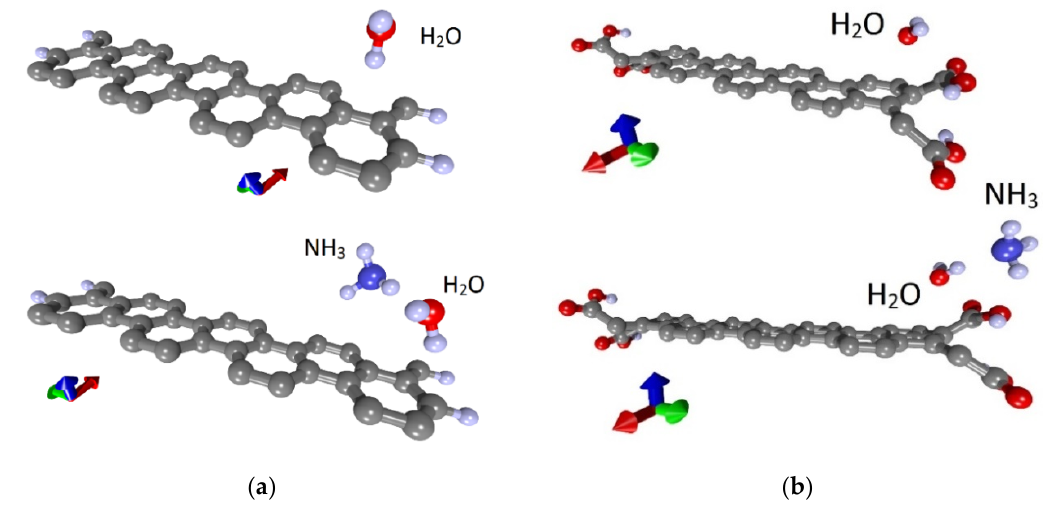
Figure 4. Adsorption of water and ammonia: ( a ) 32ZGRNR–4Hnanoribbon; ( b ) 32ZGRNR–4COOH nanoribbon (supercells of nanoribbons are shown).